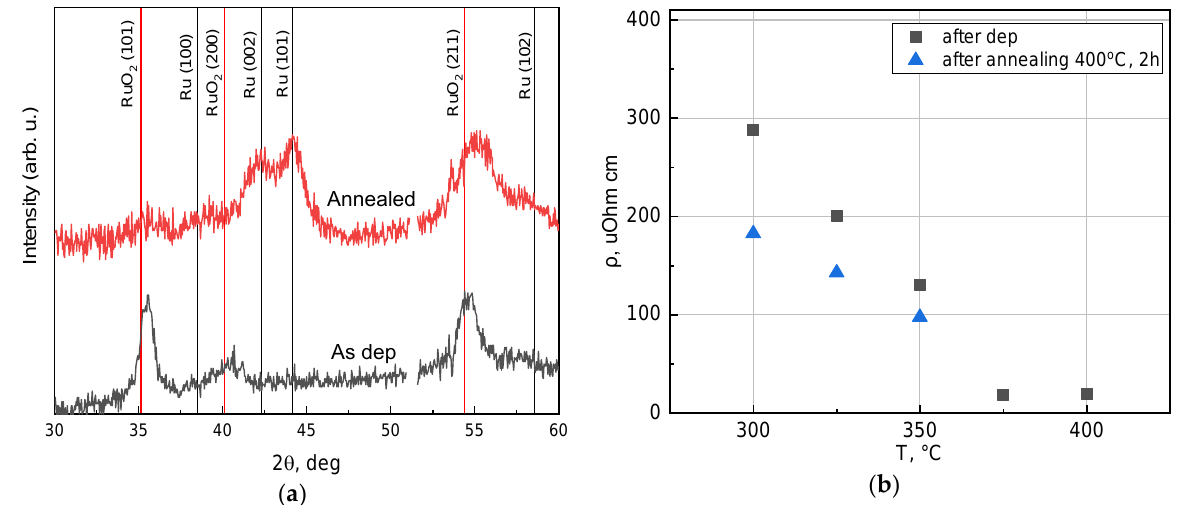
Figure 6. ( a ) GXRD spectra obtained for the film, deposited at 300 °C, before and after additional annealing at 400 °C in N 2 for 1 h; ( b ) resistivity of the samples before and after post-annealing at 400 °C in N 2 for 2 h vs. deposition temperature.